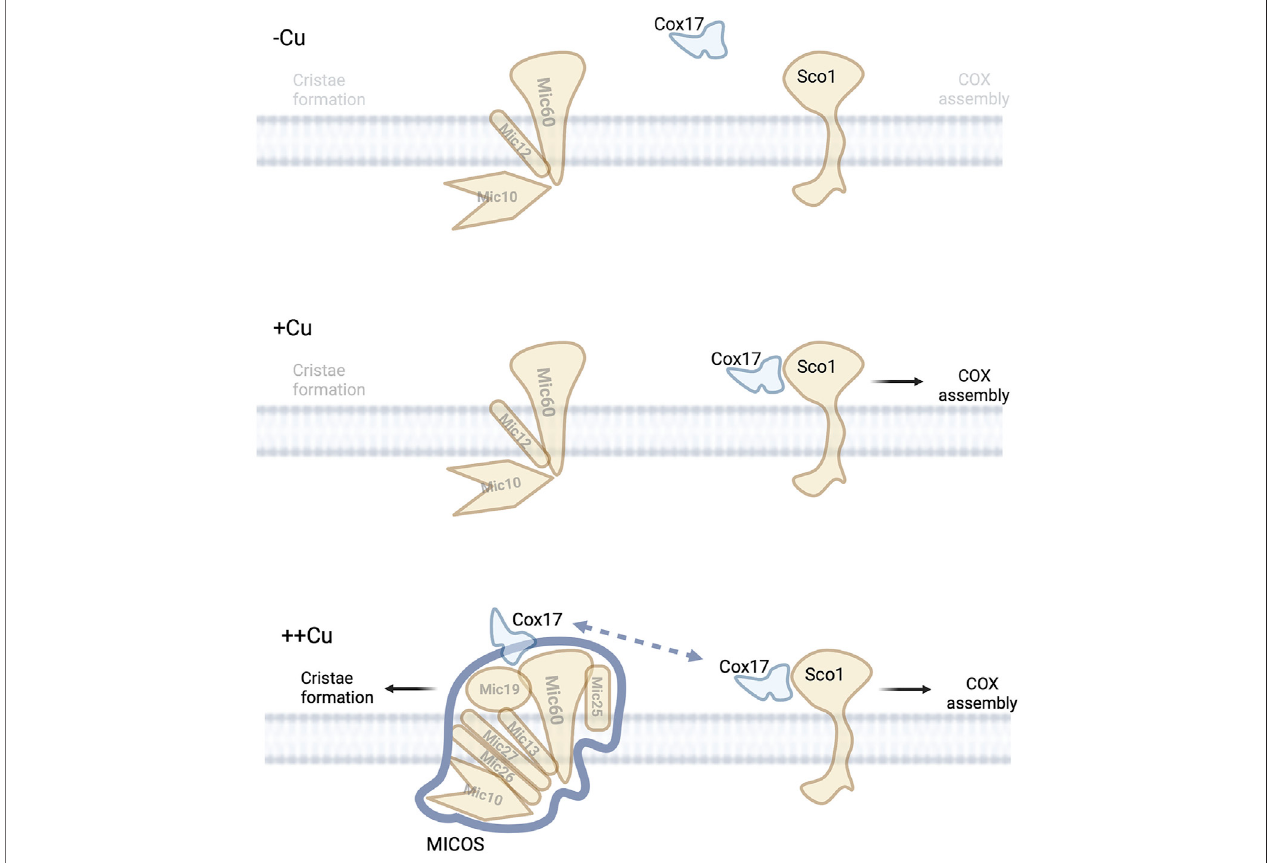
FIGURE 4 | Copper and MICOS complex. Under low copper conditions no copper is available in the IMS to mediate the assembly of COX or allow for ef fi cient assembly of MICOS suggesting low numbers of mitochondria cristae.